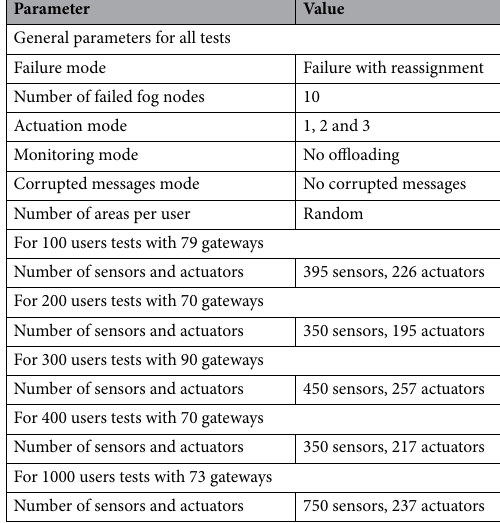
Table 5. Configuration parameters for actuation modes.